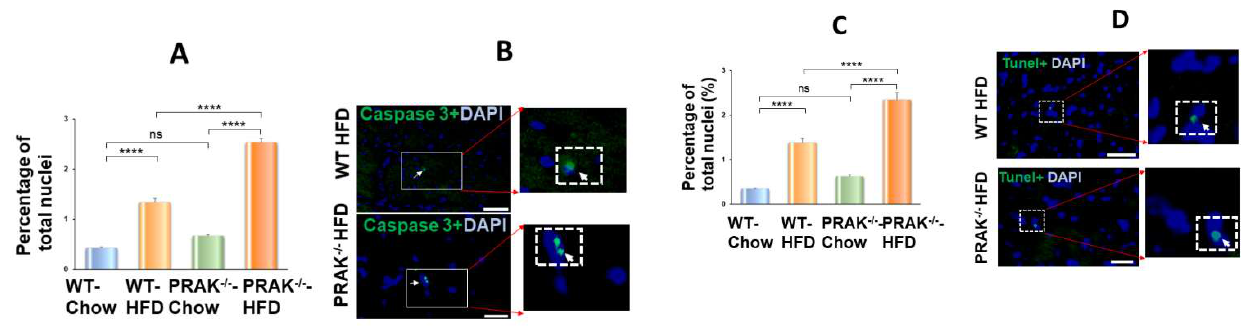
Figure 5. PRAK deletion increases interstitial fibrosis and enhances myocyte hypertrophy in the myocardium. ( A , B ): Inter- stitial fibrosis was evaluated by picrosirius red staining in hearts from wild-type (WT) and PRAK − / − mice in response to chow and HFD ( n = 3–4/per group), respectively. Data represent means ± SE ( n =3–4/per group), **** p < 0.0001. Representative images of picrosirius red staining in hearts. ( B ): Scale bar = 50 µ m). ( C , D ) : Assessment of myocyte size of myocardium in each group, respectively. Data represent means ± SE ( n = 3–4/ per group). * p < 0.05, **** p < 0.0001. Representative images of H&E staining in hearts (Scale bar = 50 µ m).